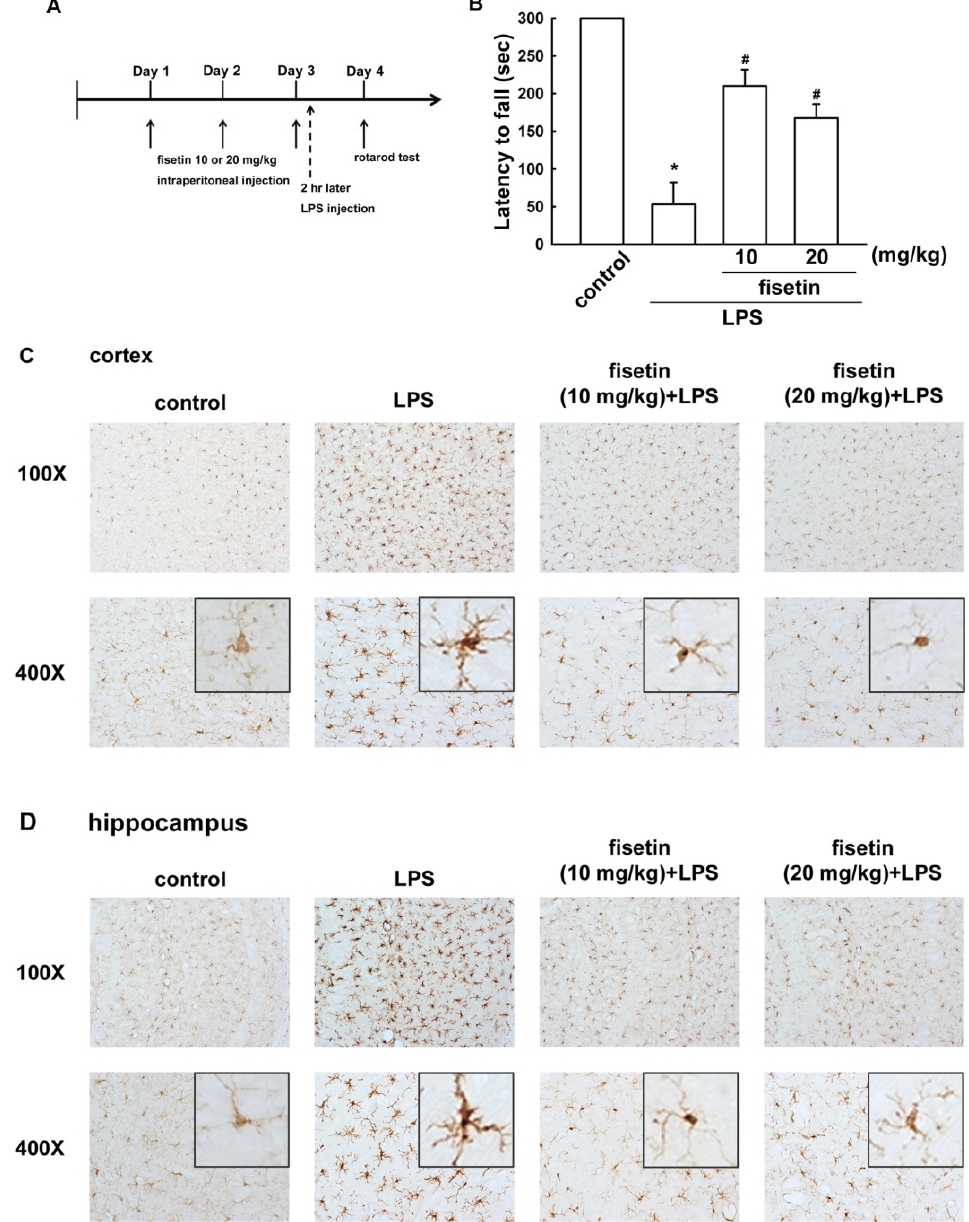
Figure 7. Fisetin prevents LPS-induced microglial activation. Mice received intraperitoneal injections of fisetin at concentrations of either 10 or 20 mg/kg once per day for 3 consecutive days. On the third day, fisetin treatment was followed with a single intraperitoneal injection of LPS (20 mg/kg). Motor balance and coordination function were analyzed using an accelerating rotarod test ( B ). Microglial morphology was visualized by anti-Iba-1 immunolabeling in cortical ( C ) and hippocampal ( D )